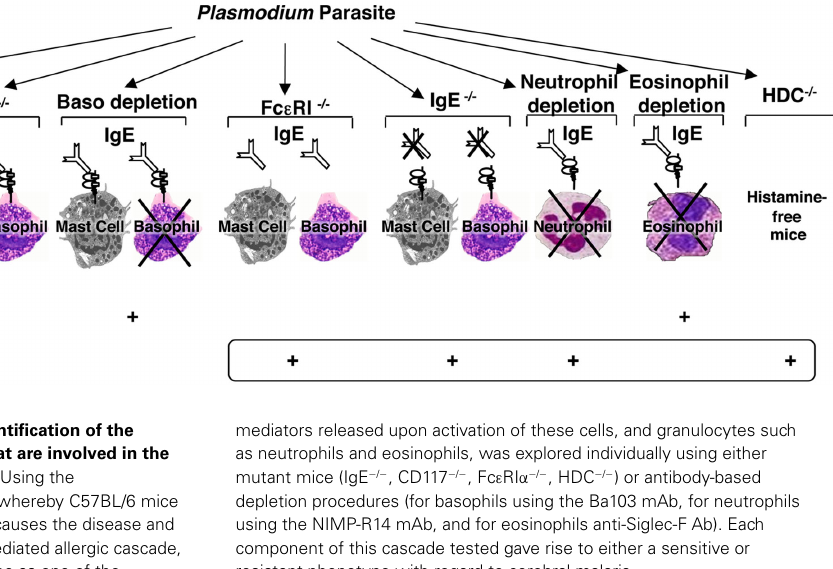
FIGURE 1 | Schematic representation of the identification of the different components of the allergic cascade that are involved in the pathogenesis of experimental cerebral malaria. Using the well-established murine model of cerebral malaria whereby C57BL/6 mice were infected with Pb ANKA parasite strain which causes the disease and mortality within 6–10days, each step of the IgE-mediated allergic cascade, including IgE, Fc ε RI, mast cells, basophils, histamine as one of the